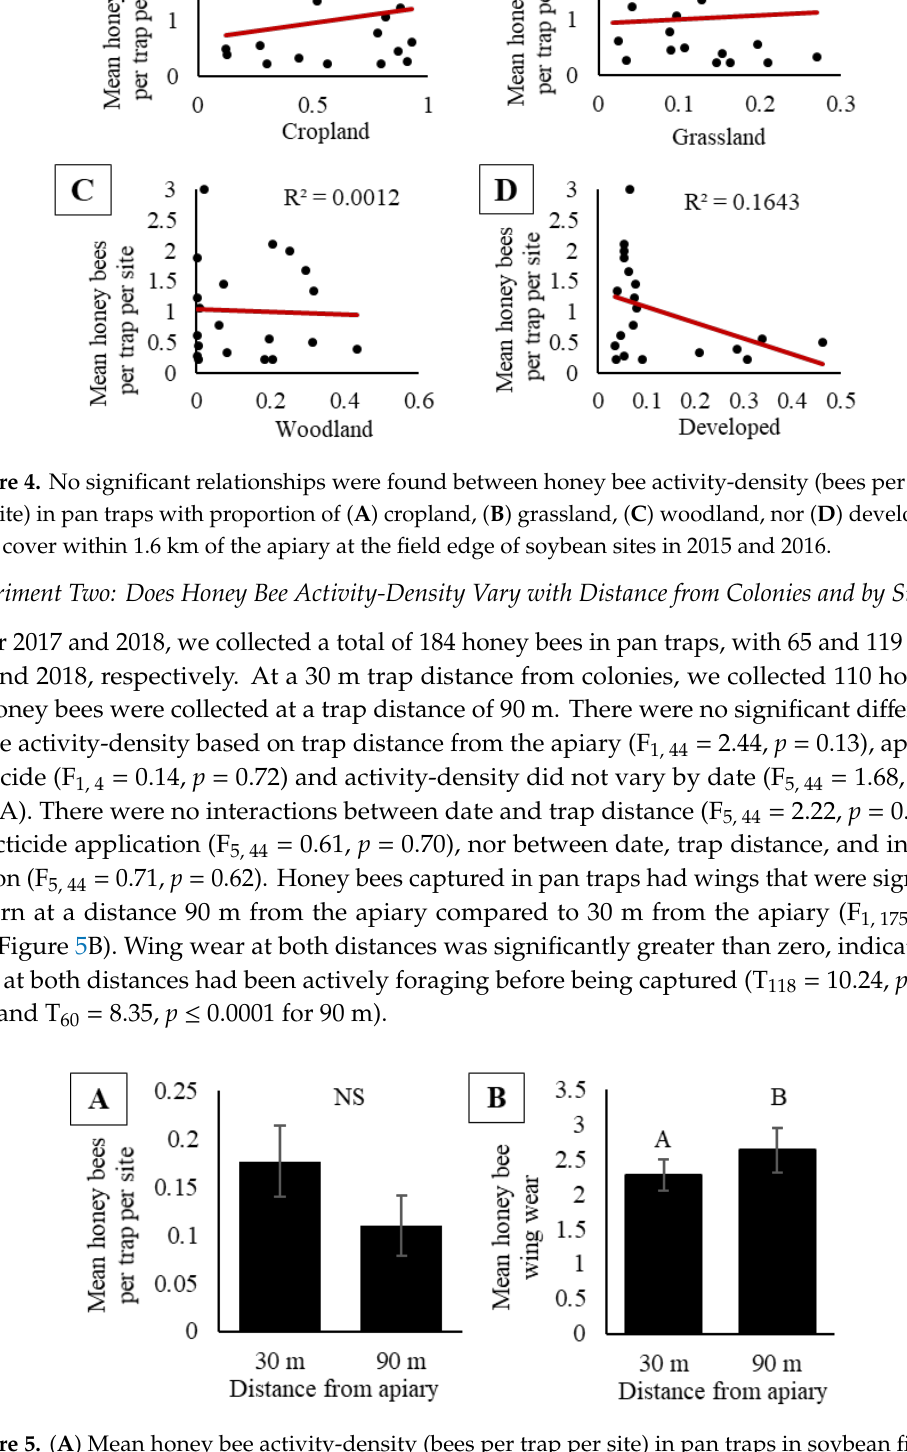
Figure 3. No significant relationships were found between honey bee activity-density (bees per trap per site per day) in pan traps with ( A ) total capped brood population at a site nor ( B ) total adult bee population at a site for each sampling day. Capped brood populations are from 2015 and 2016, while adult bee population was only measured in 2016.